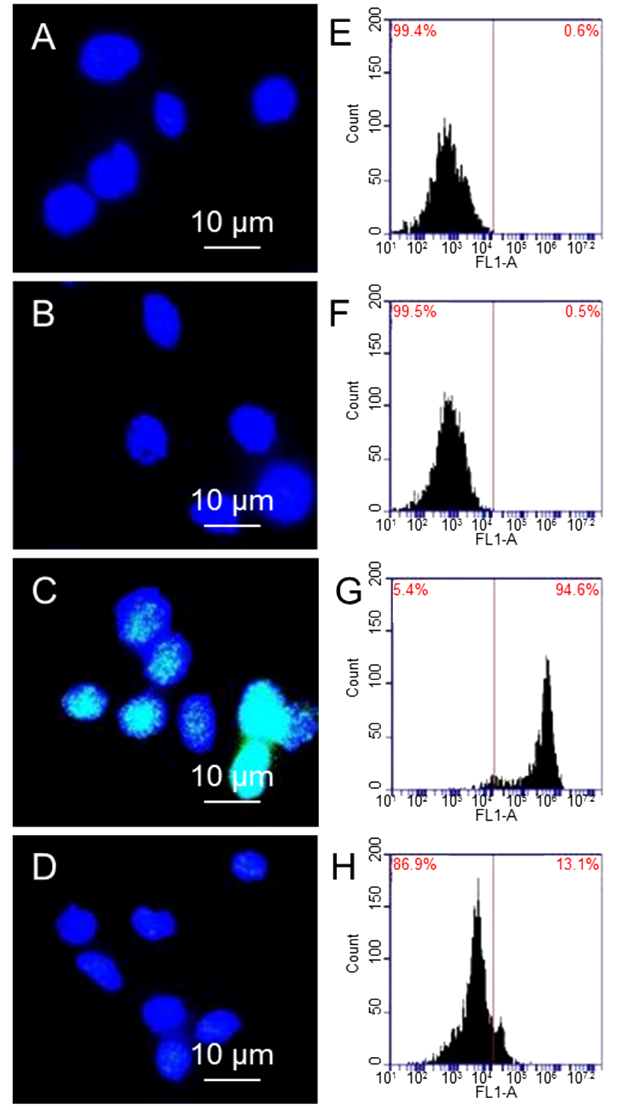
Figure 3. Immunostaining images of cells ( A ); cells treated with GO ( B ); cells exposed to X-ray ( C ); and cells treated with GO and then exposed to X-ray ( D ); flow cytometry results of cells after different treatments ( E – H